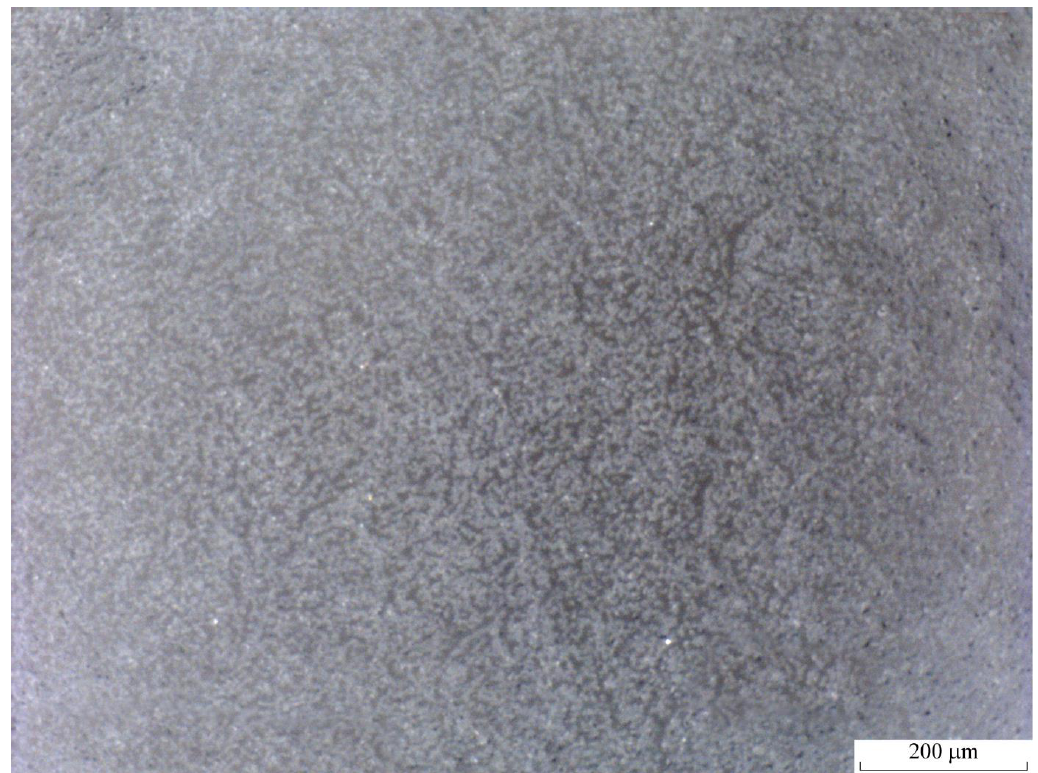
Figure 11. Xenon hydrate obtained from a drop of liquid cooled to −100 °C at a high cooling rate (100 °C/sec); observed at −14.0 °C, 2.5 atm.